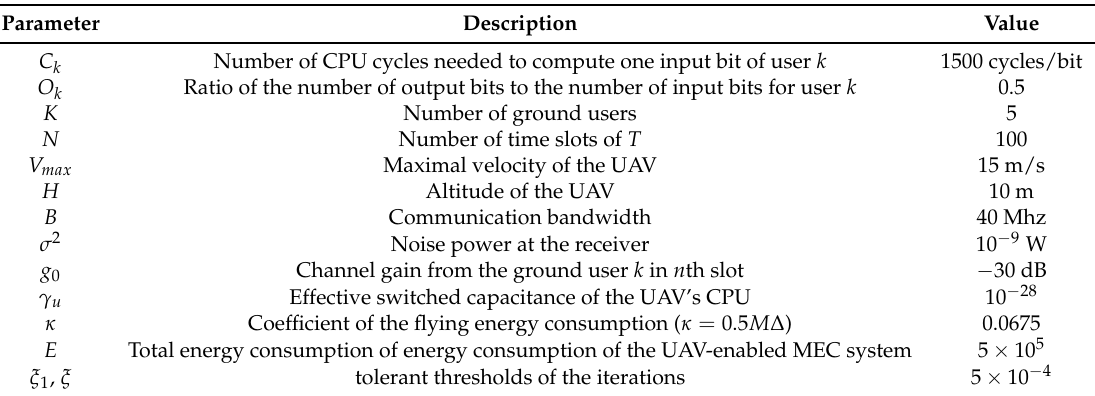
Table 2. List of symbols.